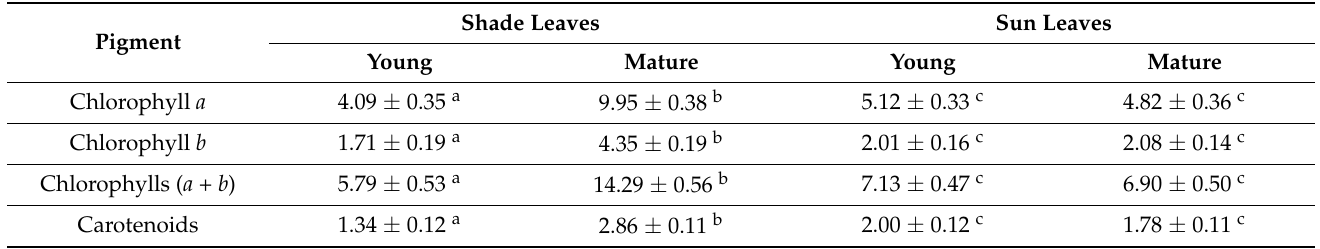
Table 2. The content of photosynthetic pigments in young and mature leaves of Hydrocharis morsus- ranae in the different lighting, mg/g dry weight ± SE.